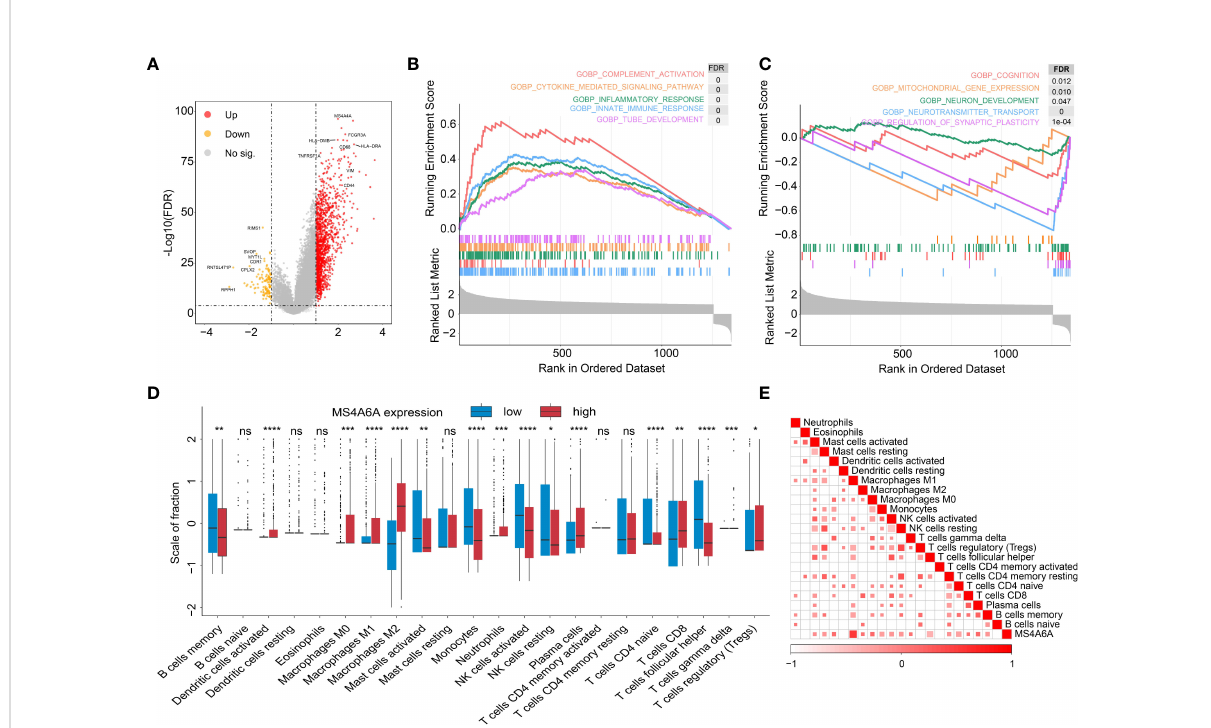
FIGURE 5 Functional annotation of MS4S6A-related genes and correlation between MS4A6A expression and immune in fi ltrates.Volcano plot of differentially expressed genes (DEGs) between high and low MS4A6A expression groups (A) . GSEA of upregulated (B) and downregulated (C) DEGs. Box plots of 22 immune cell in fi ltration levels between the high and low MS4A6A groups (D) . Correlation between MS4A6A expression and TILs (tumor-in fi ltrating lymphocytes) (E) (ns, p > 0.05, * p < 0.05; ** p < 0.01; *** p < 0.001; **** p <